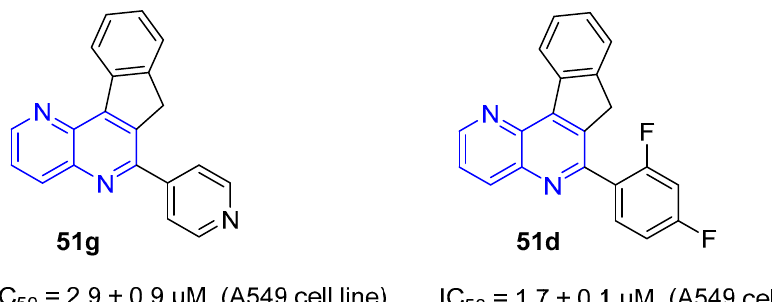
Figure 9. Cytotoxic activity of 51g and 51d on A549 cell line.